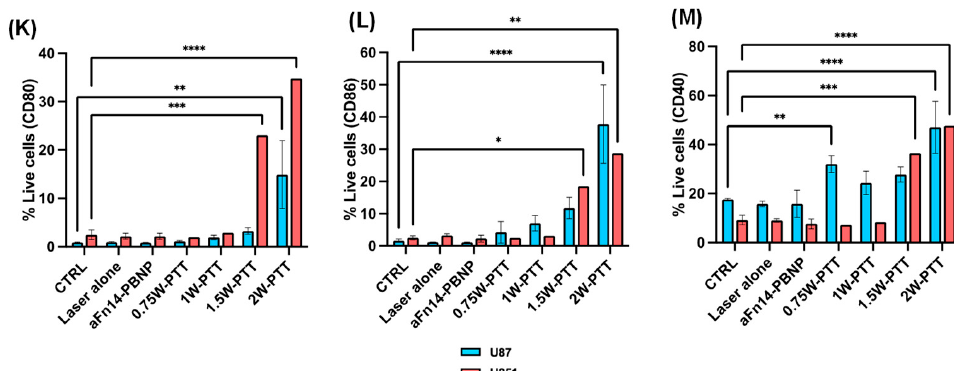
Figure 3. PTT using aFn14-PBNP triggers thermal and immunogenic cell death in treated GBM tumor lines. ( A – D ) U87 and U251 cells undergo thermal ( A ) and immunogenic cell death ( B – D ) after PTT with aFn14-PBNP, as noted by a decrease in cell viability ( A ), decrease in intracellular ATP ( B ), increase in surface calreticulin expression ( C ), and decrease in intracellular HMGB1 ( D ) with increasing laser powers (0.75–2 W). ( E – M ) PTT-induced changes in immunophenotype in GBM tumor lines, including MHC expression ( E , F ), tumor specific antigen expression ( G ), immune checkpoint inhibitor expression ( H , I ), and T cell costimulatory markers ( J – M ). CTRL = untreated cells not irradiated; laser alone = untreated cells irradiated with laser; aFn14-PBNP = aFn14-PBNP-treated cells not irradiated; remaining conditions are aFn14-PBNP-treated cells irradiated at indicated laser powers. * = p < 0.05; ** = p < 0.01; *** = p < 0.001; **** = p < 0.0001.